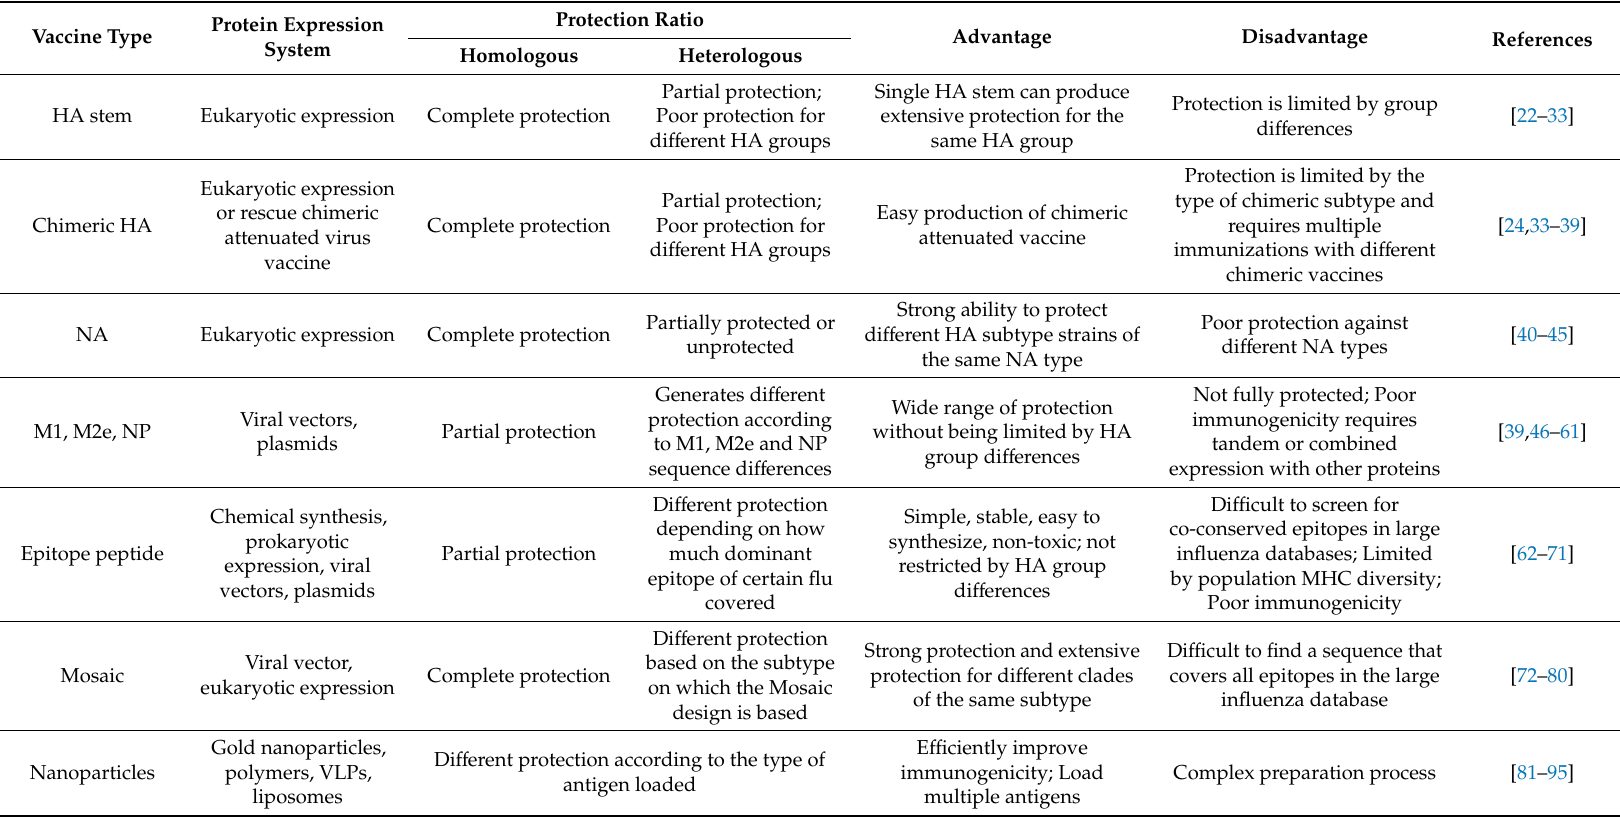
Table 1. Advantages and disadvantages of universal influenza